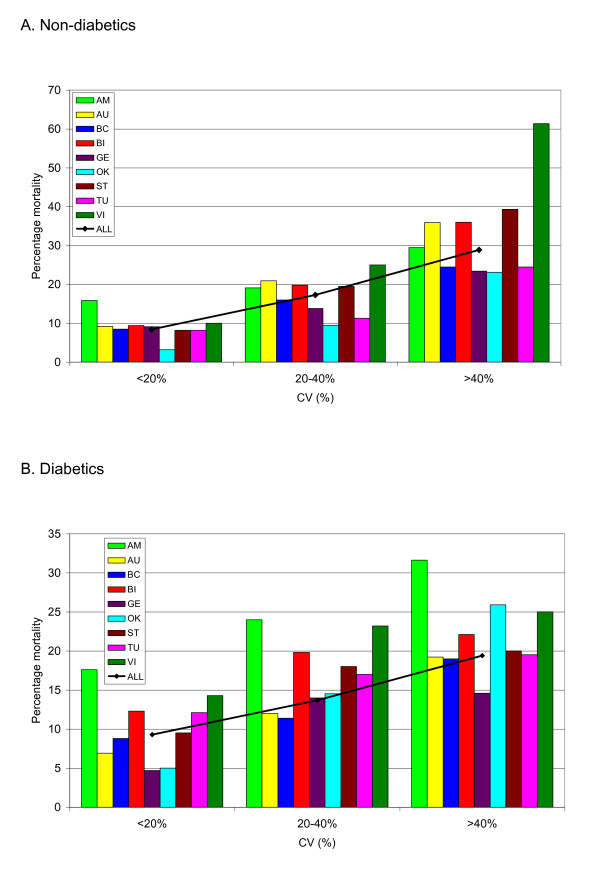
Coefficient of variation and mortality. The relationp of coefficient
of variation (%) to mortality in nondiabetes (A) and diabetes (B)
patients for each of the nine cohorts as well as the entire population.
Cohorts with fewer than 20 patients in a particular "band" are not
reported.